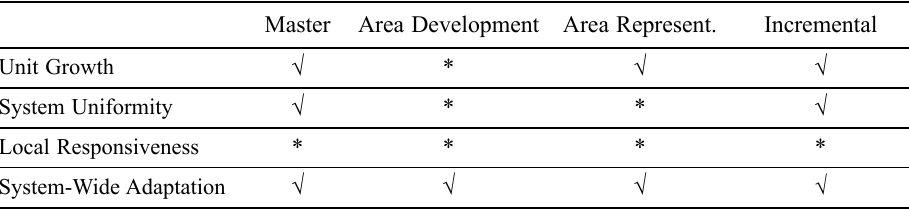
Table 6. Overview of hypotheses